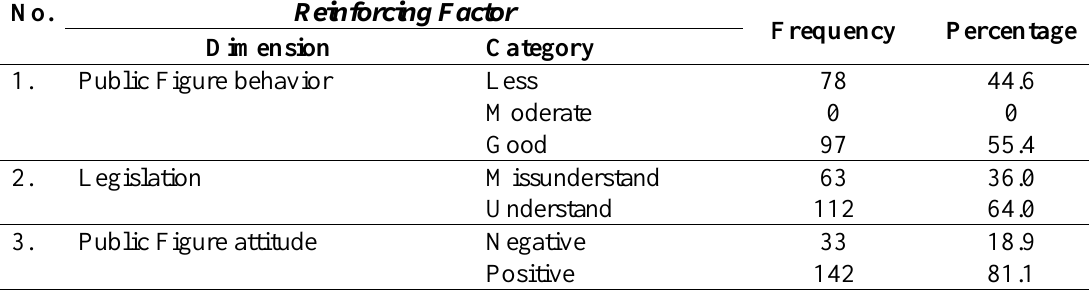
Table 3. Distribution of respondents based on Reinforcing Factor at Puskesmas, Surabaya, 2016 No.